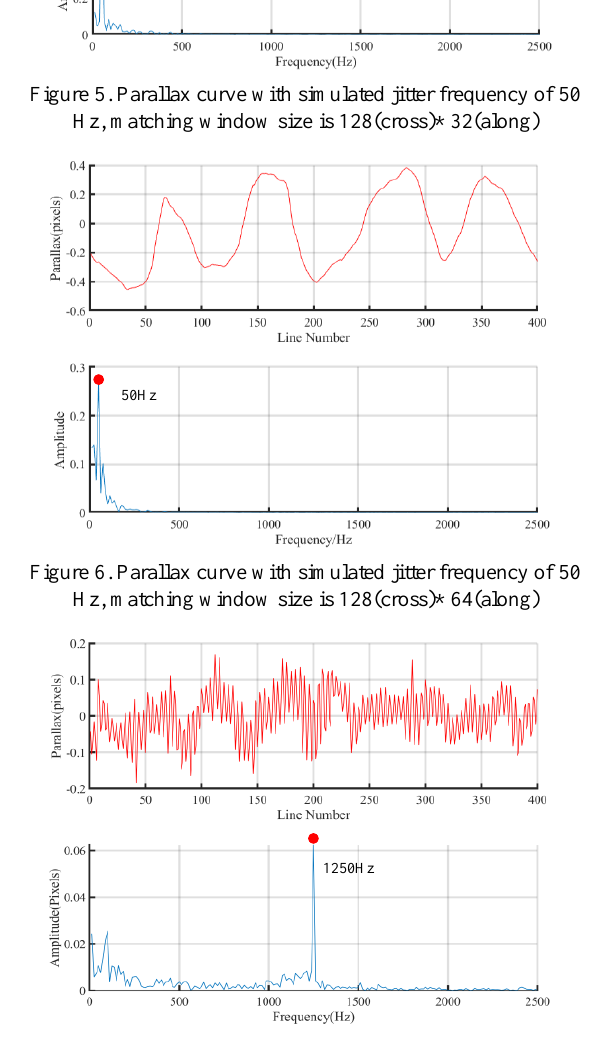
Figure 7. Parallax curve with simulated jitter frequency of 1250 Hz, matching window size is 128(cross)* 16 (along)